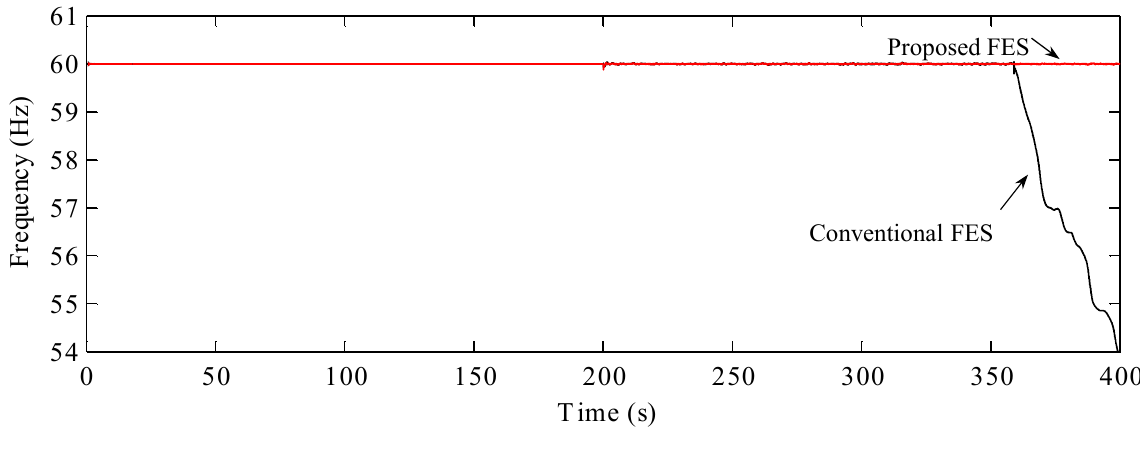
Figure 15. Frequency of the microgrid.